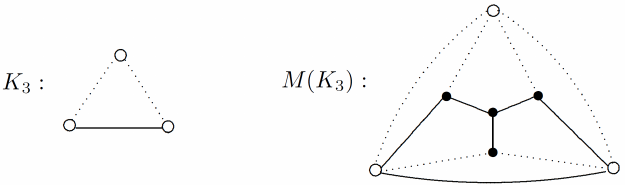
Figure 7: Red-blue colorings of K 3 and M ( K 3 ) avoiding a monochromatic K 3